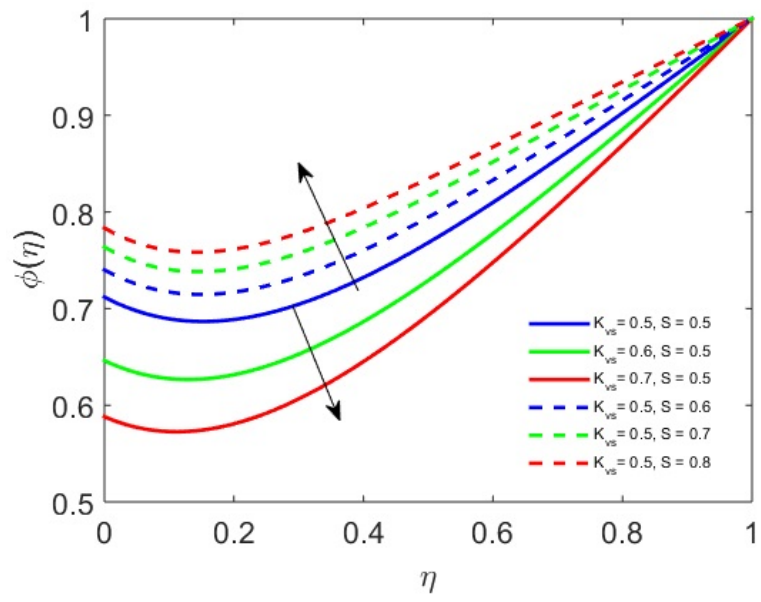
φ versus vs K and S